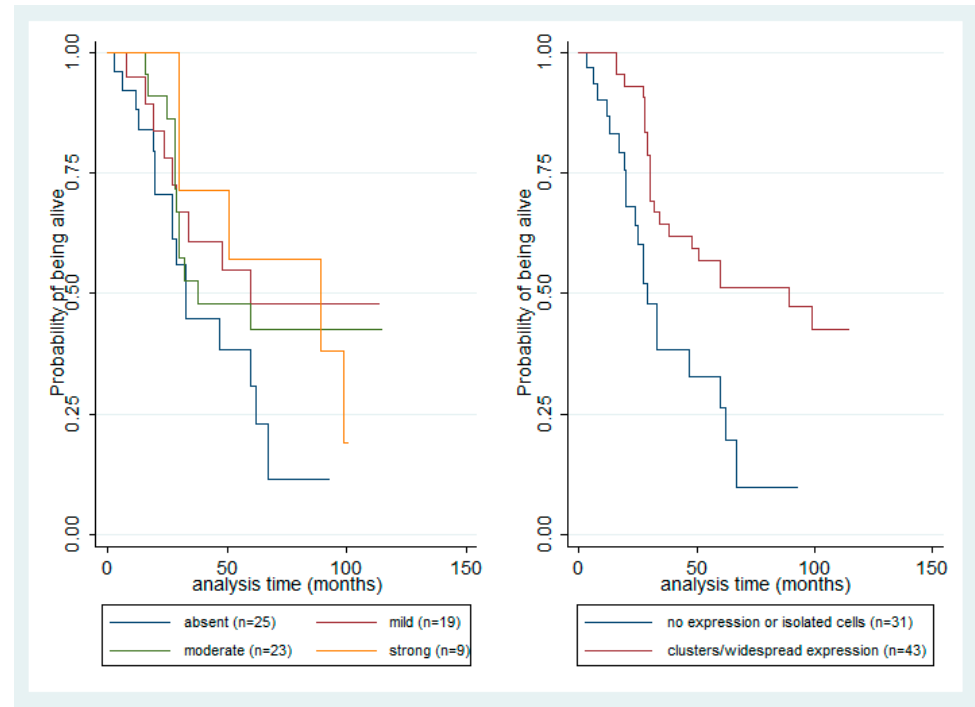
Figure 4. Kaplan–Meier survival curves according to four levels of HDAC-2 nuclear IRS (absent, mild, moderate, strong) and the patter of heterogeneous expression of HDAC-2 in UMs. Table 3. Cox proportional hazards models in UMs including HDAC-nuclear IRS and pattern of heterogeneous staining. Model A Hazard Ratio (HR) p 95% Confidence Interval HDAC-2 nuclear IRS 0.286 0.001 0.133 0.618 Tumor